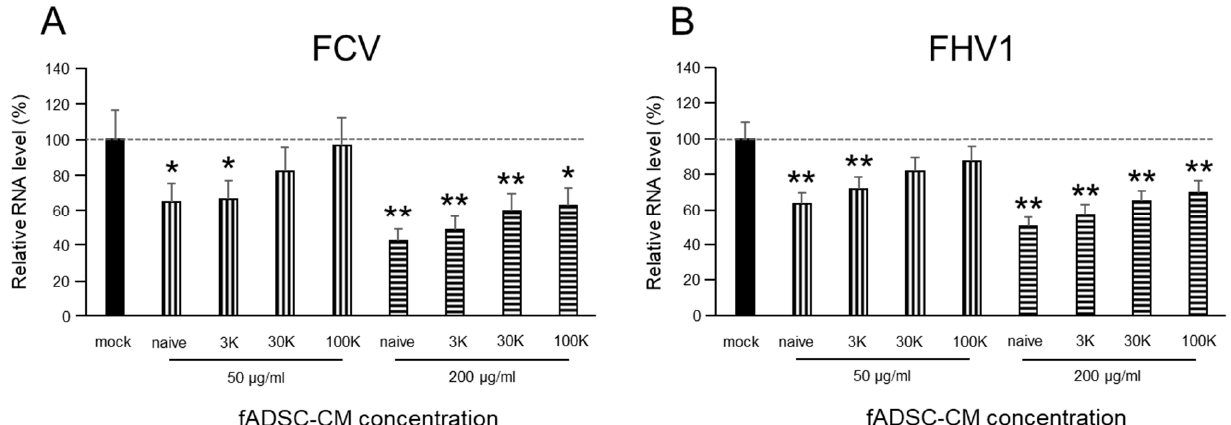
Figure 2. Evaluation of the effects of fAD-MSC-CM on viral replication ( A ) Relative FCV viral mRNA levels in CRFK cells. ( B ) Relative FHV1 viral mRNA levels in CRFK cells. Data are expressed as the mean ± standard deviation. Asterisks indicate significant differences compared with mock-treated group (*, p < 0.05; **, p < 0.01).